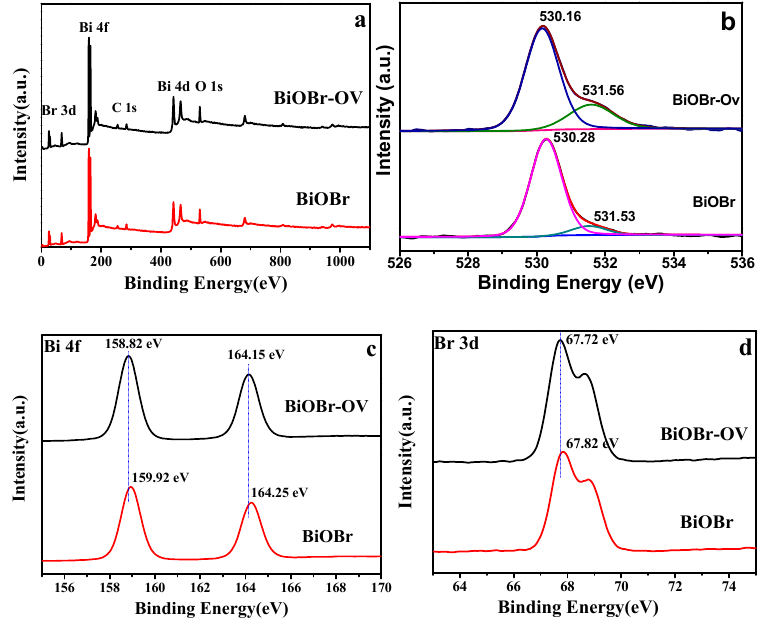
Figure 5. ( a ) Survey X-ray photoelectron spectroscopy (XPS) spectra and high-resolution XPS spectra of ( b ) O 1s, ( c ) Bi 4f and ( d ) Br 3d for BiOBr and BiOBr-OV sample.